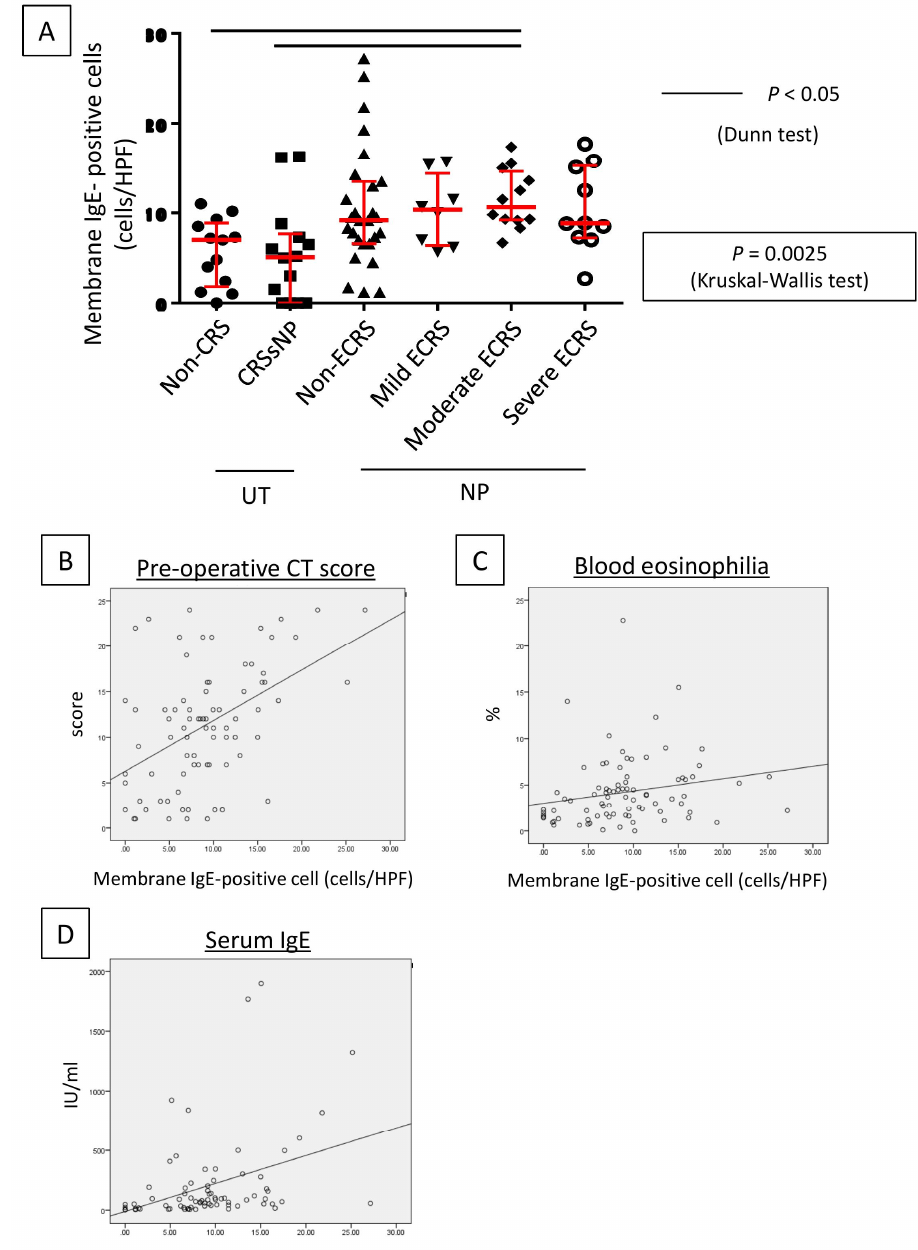
Figure 5. Lesion infiltration by membrane IgE-positive cells and the number of IgE-positive cells. ( A ) Determination of membrane IgE-positive cell number in the hotspot of each case. The number of membrane IgE-positive cells increased in the nasal polyp groups ( p < 0.0025, Kruskal–Wallis test). Relationships between the number of membrane IgE-positive cells and the preoperative CT score ( B ), eosinophil ratio in peripheral blood ( C ), and total serum IgE level ( D ). Furthermore, cytoplasmic IgE ‐ positive mast cells were found in lesions of moderate and severe ECRS (Figure 6A–F). The number of these cells was statistically higher in moderate and severe ECRS than in the other groups ( p < 0.05 and p < 0.01, respectively; Figure 6G). The number of cytoplasmic IgE ‐ positive mast cells was also significantly correlated to radiological severity of CRS (r = 0.280, p =